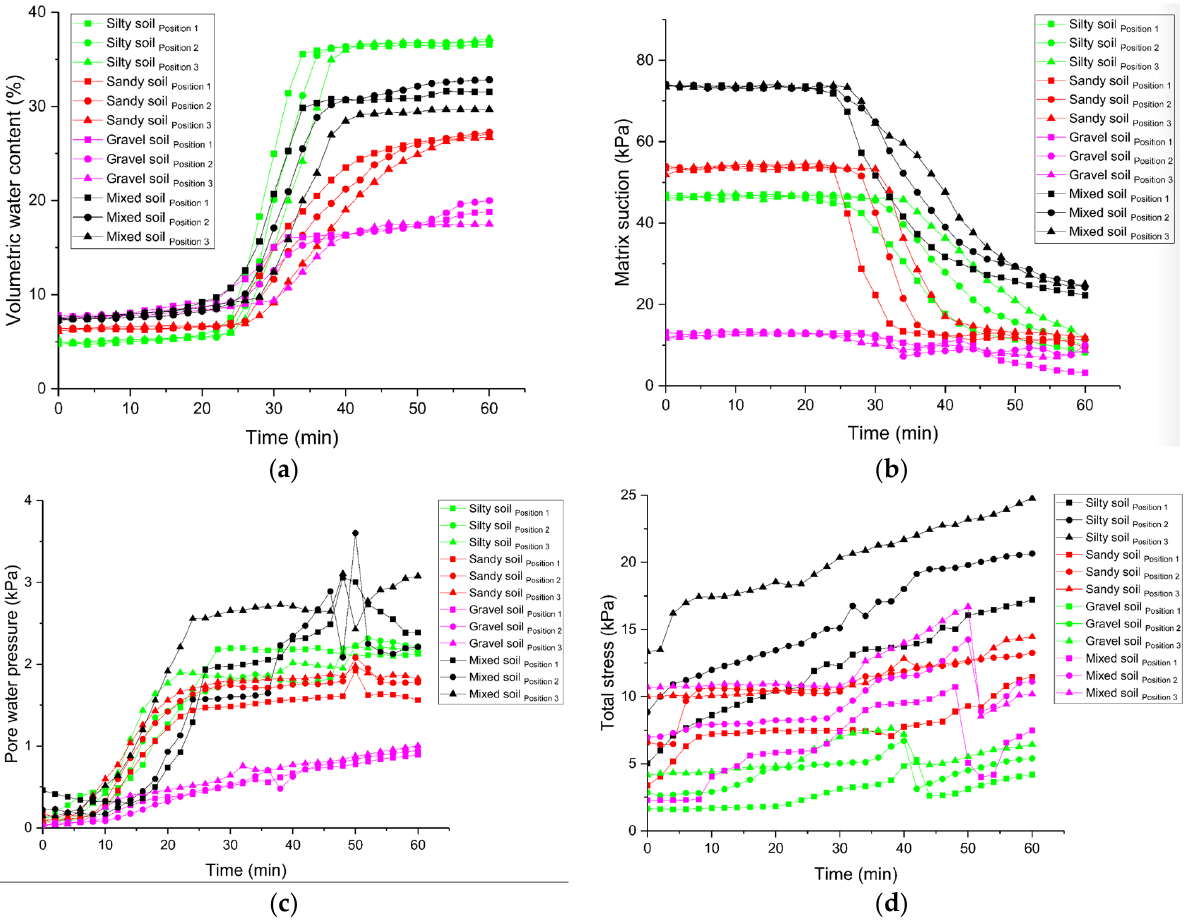
Figure 7. Variation in measured data when soil types are different: ( a ) water content; ( b ) matrix suction; ( c ) pore water pressure; ( d ) total stress.